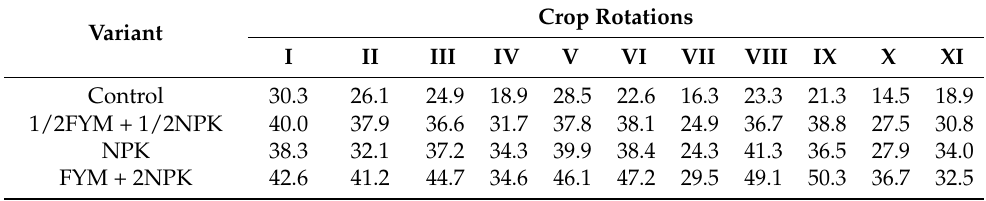
Table 1. The productivity of grain crop for the rotation, 1968–2018, centner of grain units per hectare.